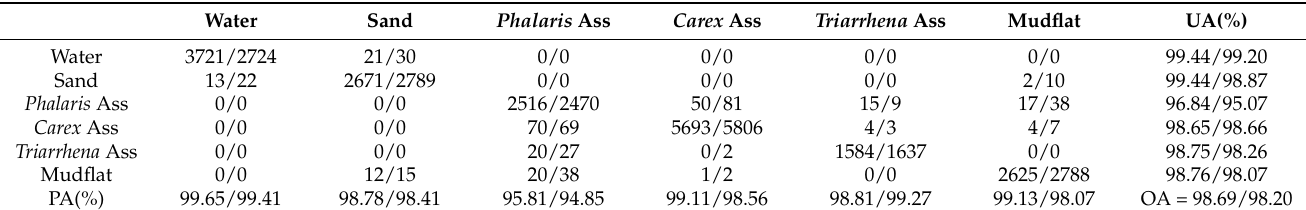
Table A3. Accuracy matrix of the training/validation set.